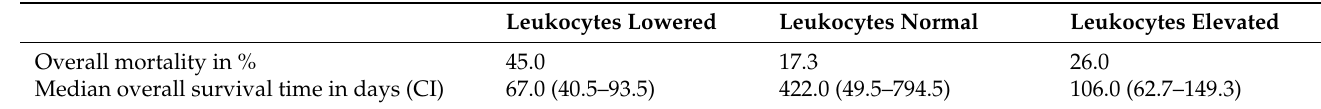
Table 7. Impact of leukocyte counts on patient